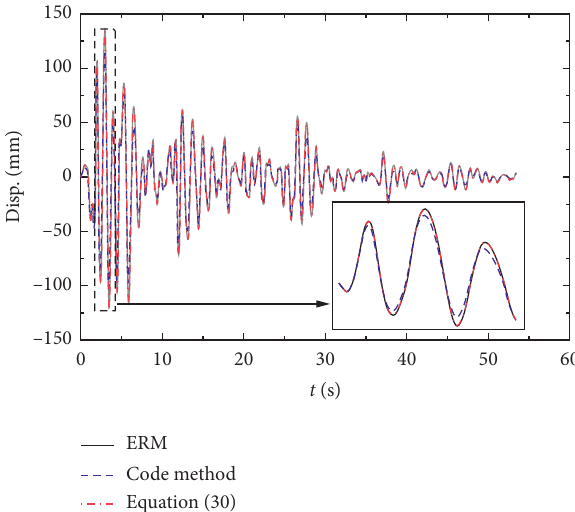
Figure 16: Roof-displacement time histories of the shear frame with ADRs calculated using different